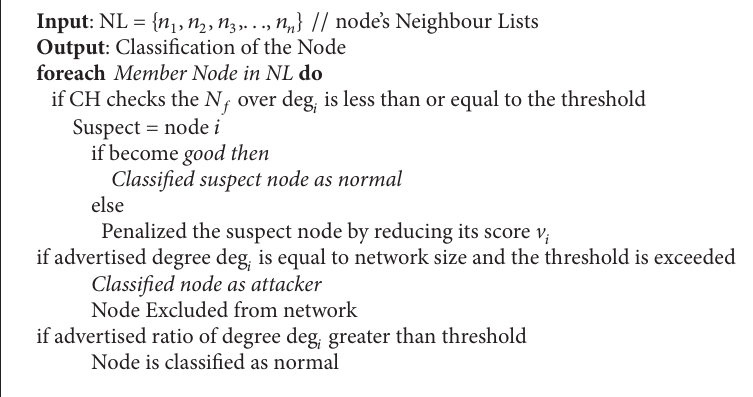
Algorithm 2: Byzantine agreement node classification